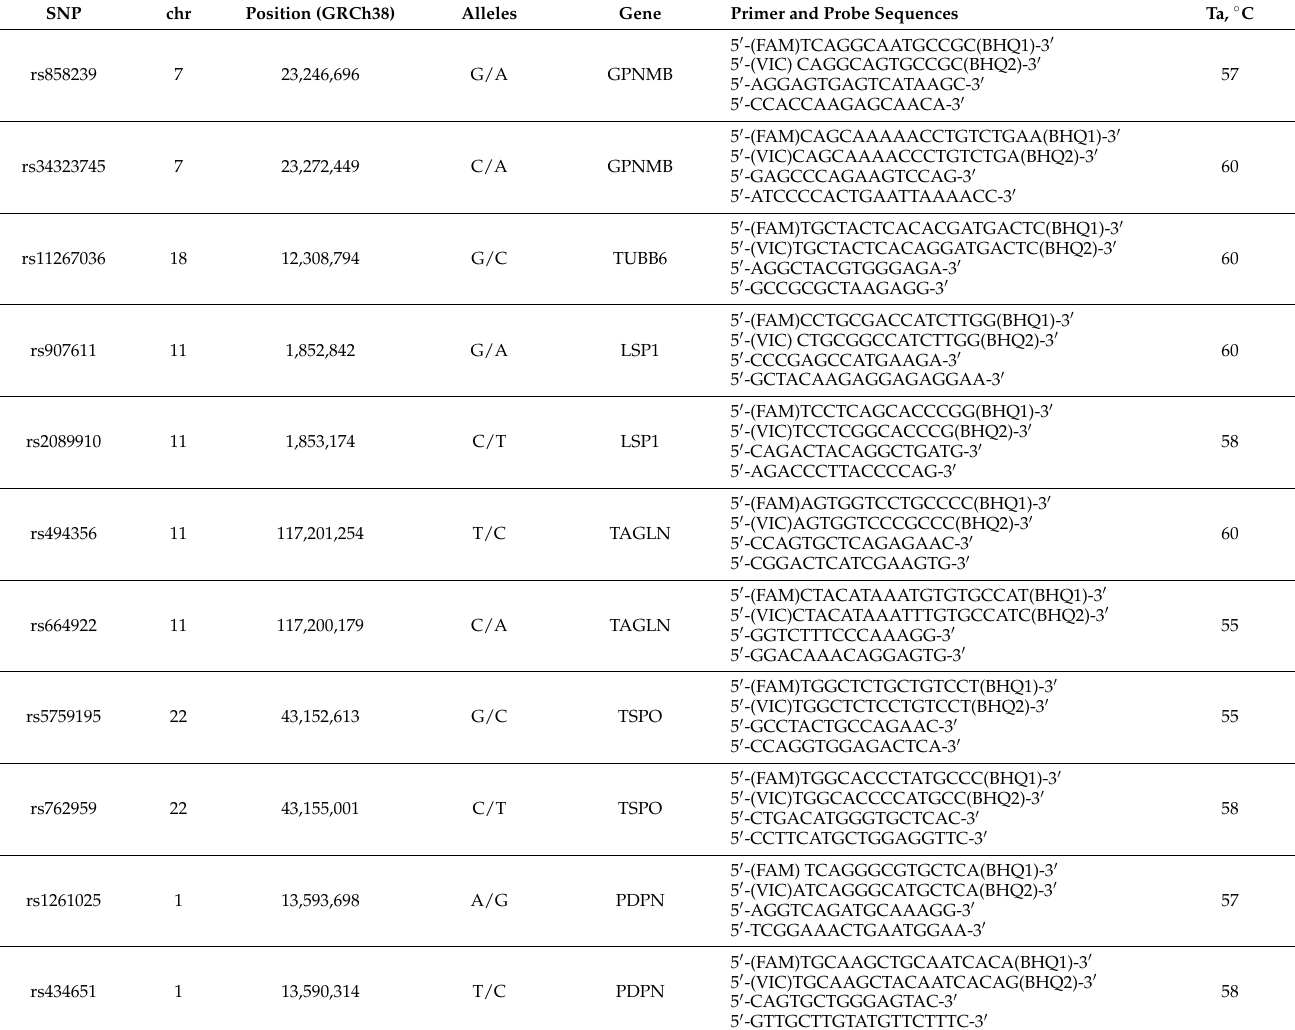
Table 4. Genomic characteristics of the polymorphisms studied, with primer and probe sequences and PCR conditions